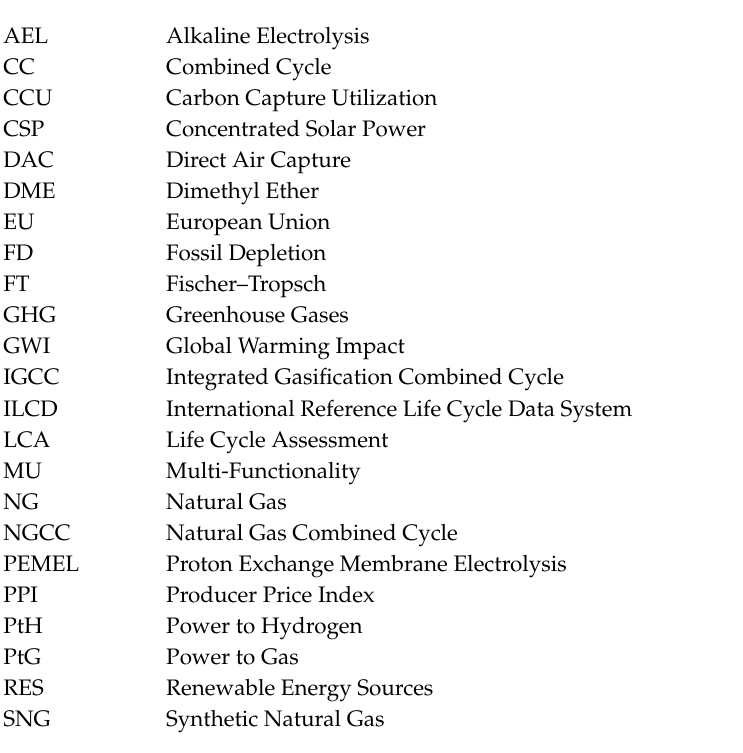
Table S1: Life Cycle Inventory input matrix, Table S2: Impact assessment of CO 2 capture from various CO 2 sources (functional unit 1 kg of CO 2 ), Table S3: Contribution analysis for 1 kg SNG production, average among the CO 2 sources, Table S4: Impact assessment for 1 kg SNG production from di ff erent CO 2 sources, Table S5: Impact assessment of 1 kg SNG production with di ff erent MU